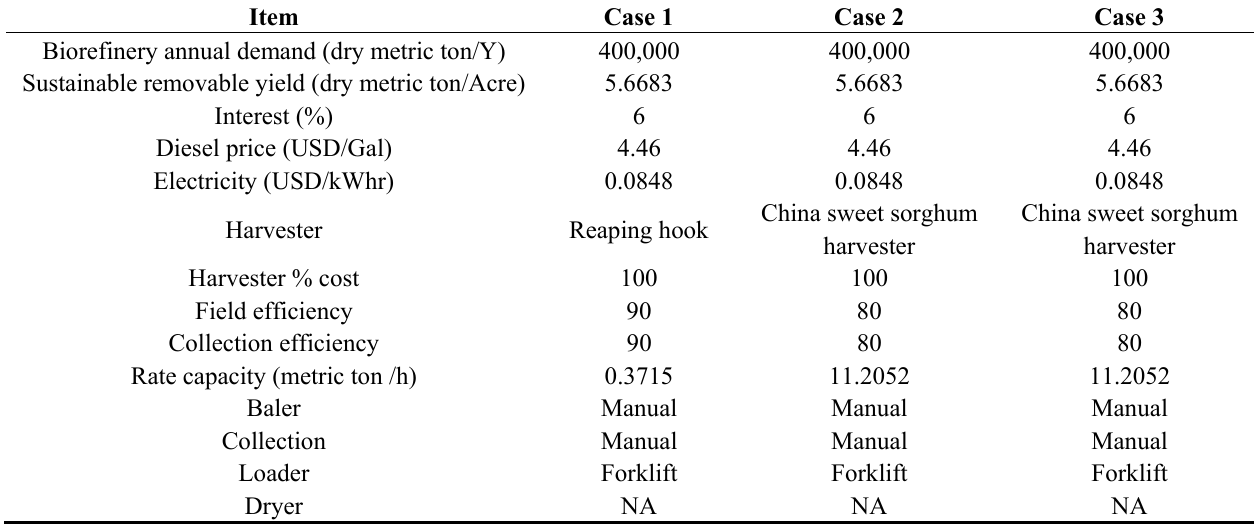
Table B1. Equipment and other elements used during harvesting and collection.